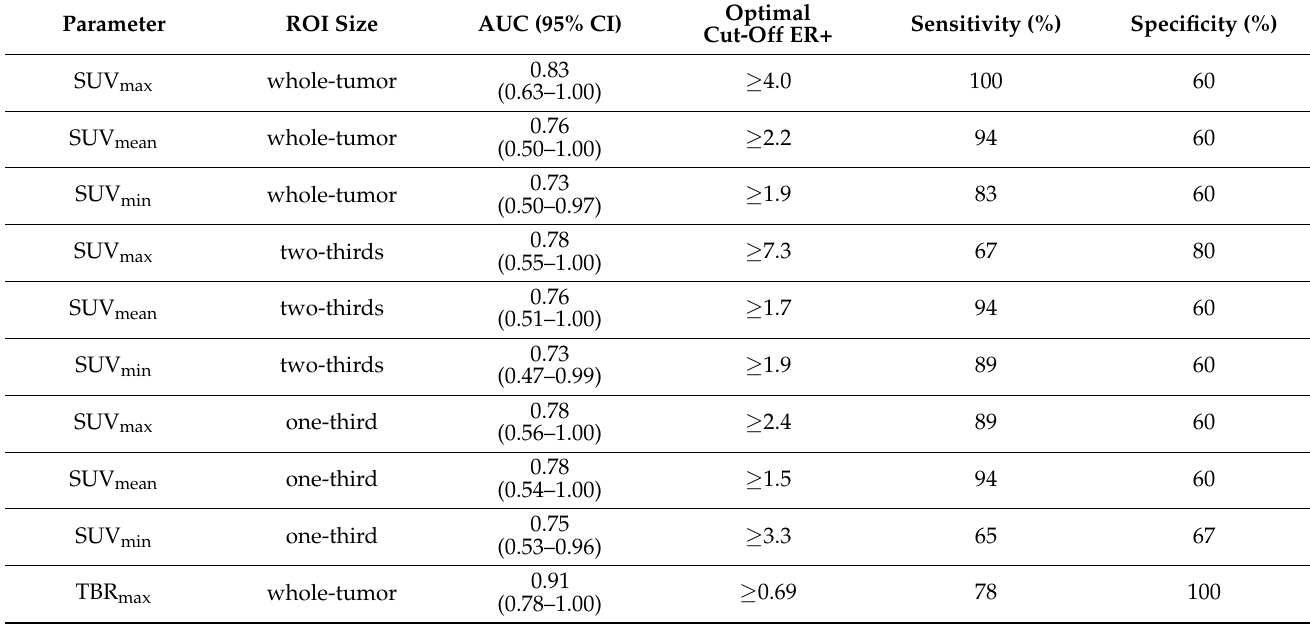
Table A2. The discriminative power of [ 18 F]-FES-PET to stratify liver metastases by ER status ( n = 23), using a cut-off value of ≥ 1% for ER